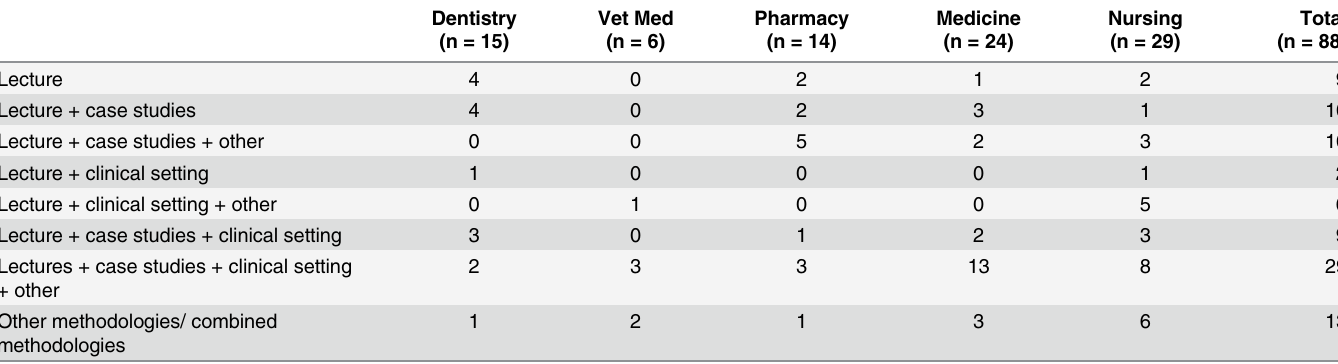
Table 3. Antimicrobial stewardship teaching methodologies used in undergraduate education programmes, by discipline.